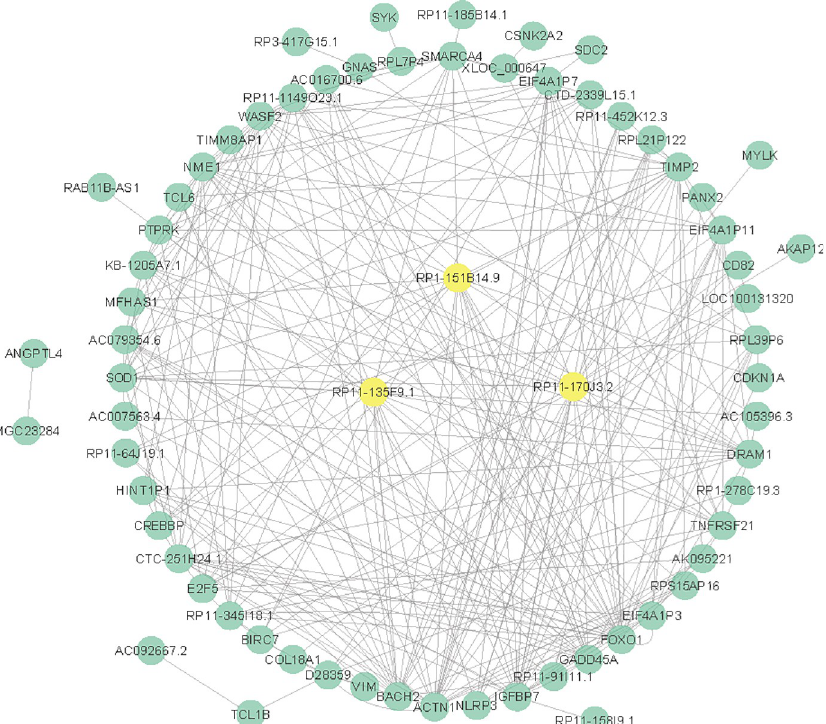
Fig 5. The construction of lncRNA-mRNA network. The lncRNA-mRNA pairs which satisfied PCC > 0.6 and p- value < 0.001 were shown in the network. RP11-170J3.2, RP11-135F9.1 and RP1-151B14.9 were the top 3 lncRNAs that had the most edges with other mRNA nodes.